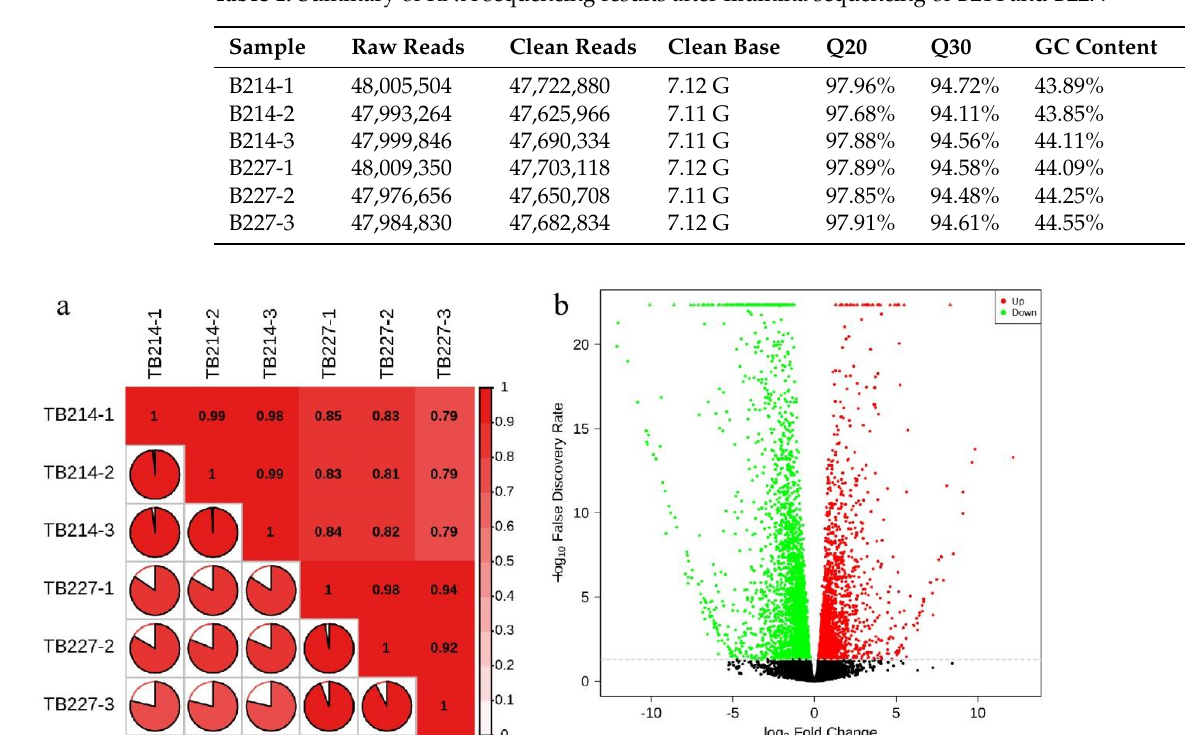
Figure 3. Statistical analysis of transcriptomic data of mature pericarps of B227 and B214: ( a ) Heatmap illustrating correlations between the two individual datasets based on R 2 . Red color indicates a stronger correlation and white color indicates weak correlation. ( b ) Volcano plot showing DEGs between mature pericarp of B214 and B227. X -axis represents log2FoldChange (B214/B227) and y -axis represents − log10 ( p -value). Red and green dots indicate up-regulated and down-regulated genes, respectively. Black dots represent non-DEGs between B227 and